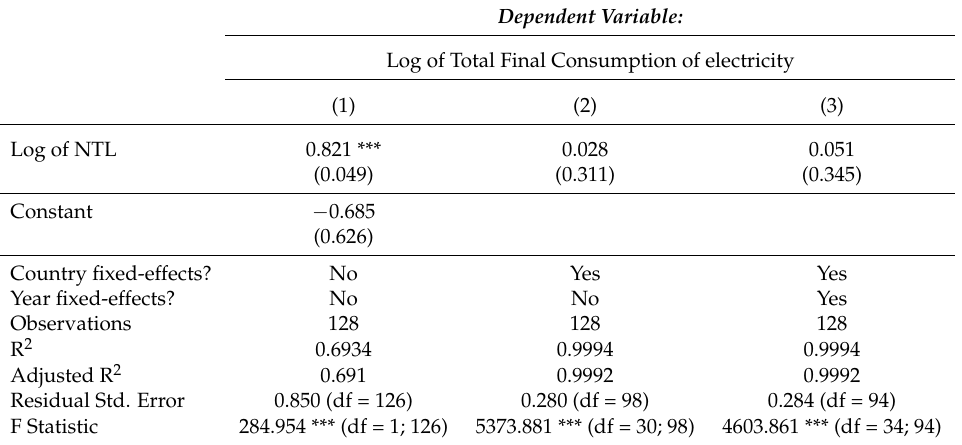
Table A3. Regression for COMMPUB—Higher-middle income countries.